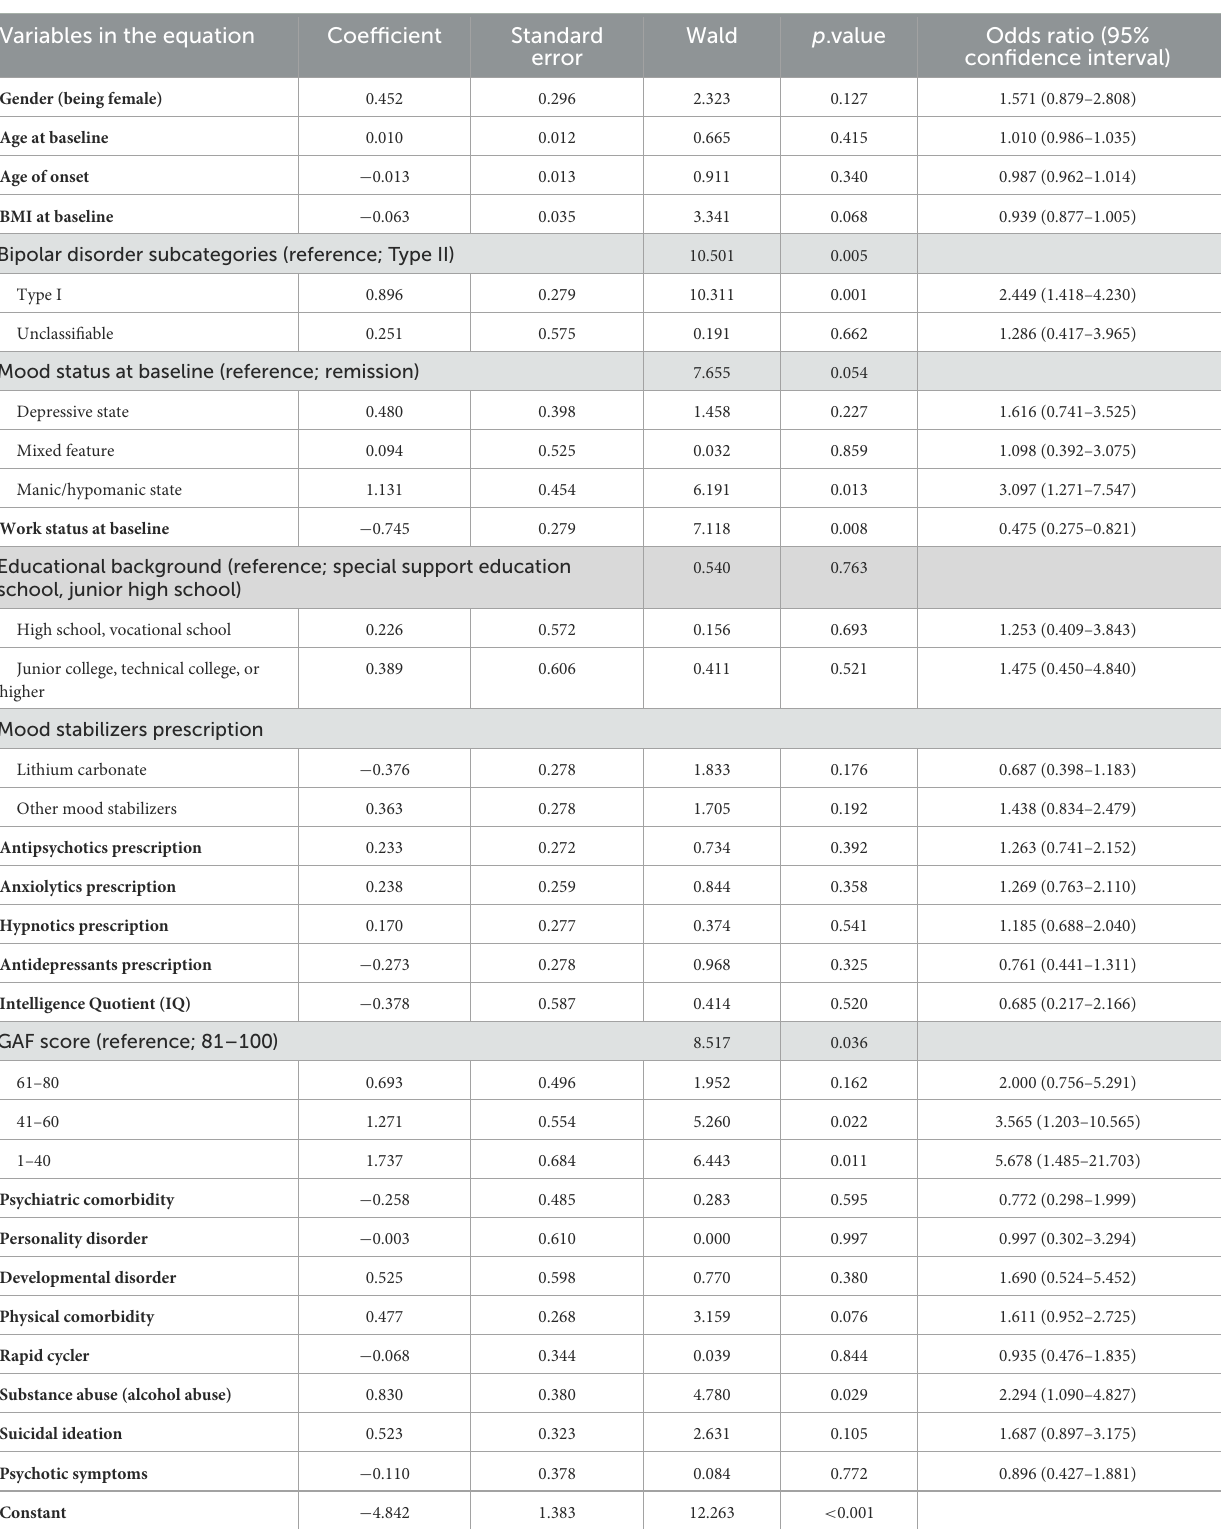
TABLE 3 Binomial logistic regression analysis of factors for psychiatric hospitalization among all